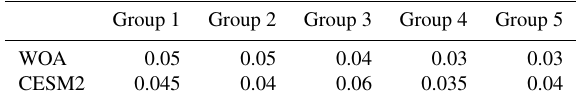
Table 1. The radius ε used in the DBSCAN for WOA and CESM2.